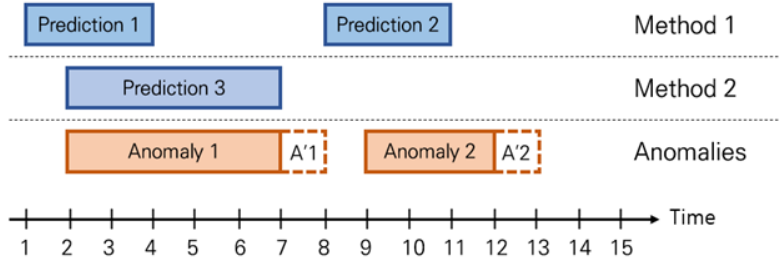
Figure 3. Anomaly detection case to explain problems with existing performance metrics. Table 2. Precision and recall for methods 1 and 2.